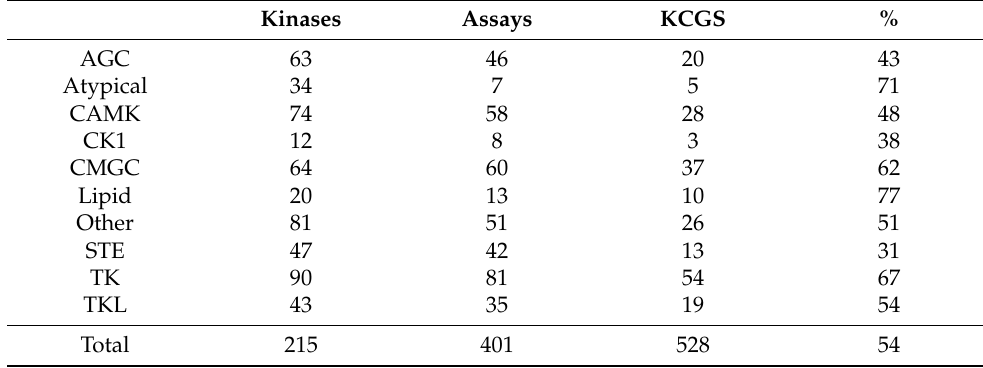
Table 1. Kinase coverage by kinase chemogenomic set (KCGS) version 1. The human kinases are divided into 10 subfamilies [23]. Kinases: the number of human kinases in each subfamily. Assays: the number of kinases in the DiscoverX scanMAX panel. KCGS: The number of kinases covered by an inhibitor. %: The percentage of kinases screened that are covered by an